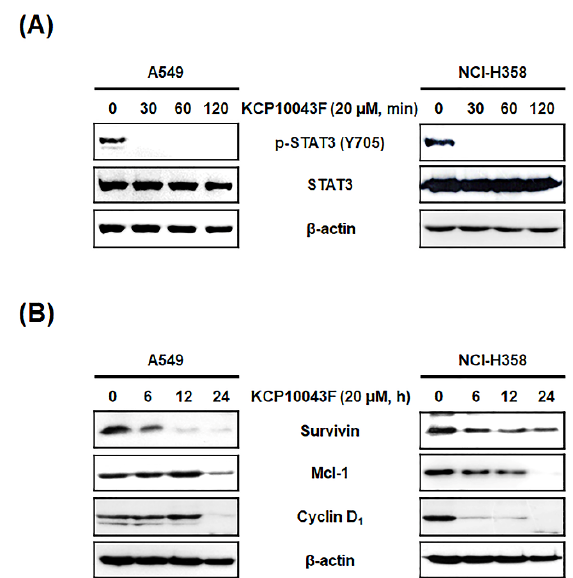
Figure 4. Suppression of the signal transducer and activator of transcription (STAT3) signaling pathway by KCP10043F in A549 and NCI ‐ H358 cells. ( A ) After treatment with 20 µM KCP10043F for the indicated times (30, 60, or 120 min), total cell lysates were prepared and analyzed using specific p ‐ STAT3 and STAT3 antibodies. ( B ) Cells were treated with 20 µM KCP10043F for the indicated times (6, 12, or 24 h). Total cellular proteins were prepared, resolved by SDS–PAGE, and detected using